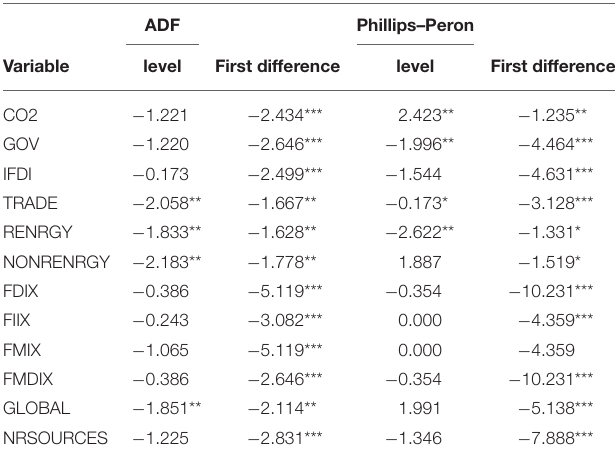
TABLE 3 | Unit root test results. TABLE 4 | Results for dynamic ARDL